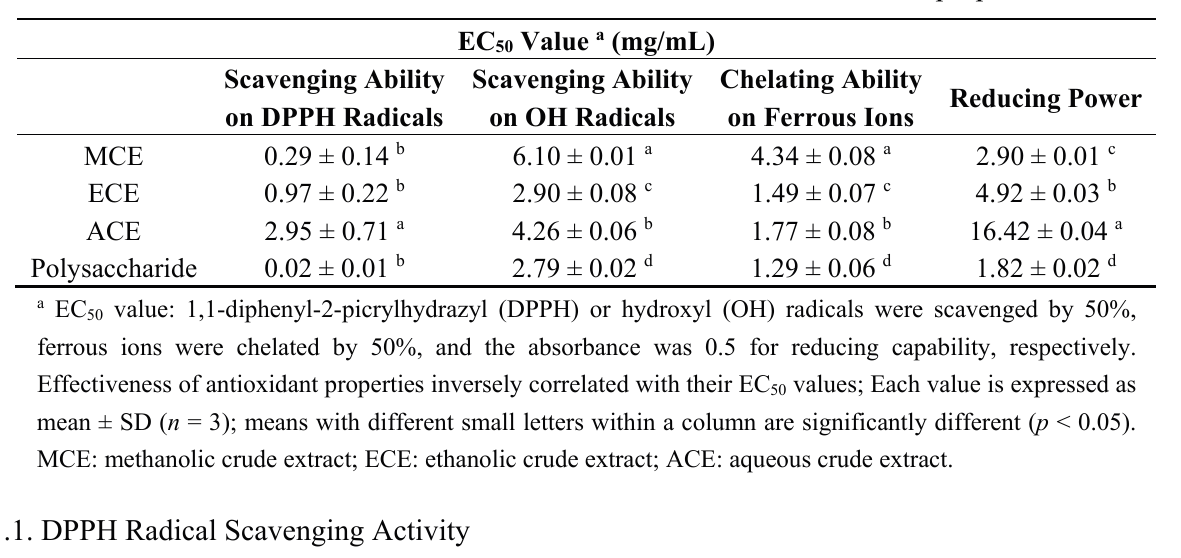
Table 1. EC 50 values of four extracts from mushroom in antioxidant properties.